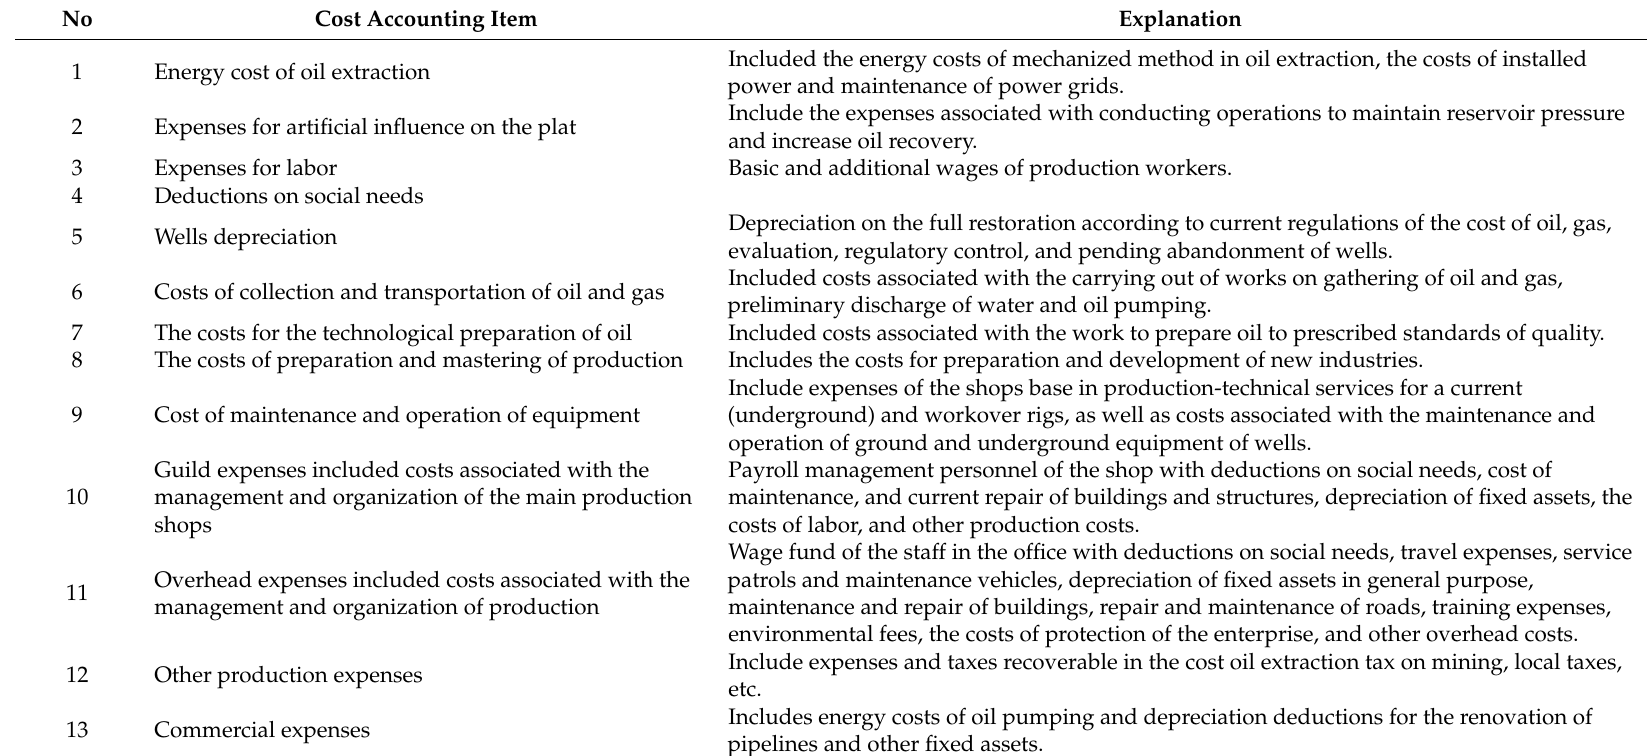
Table A1. Output cost of hydrocarbon